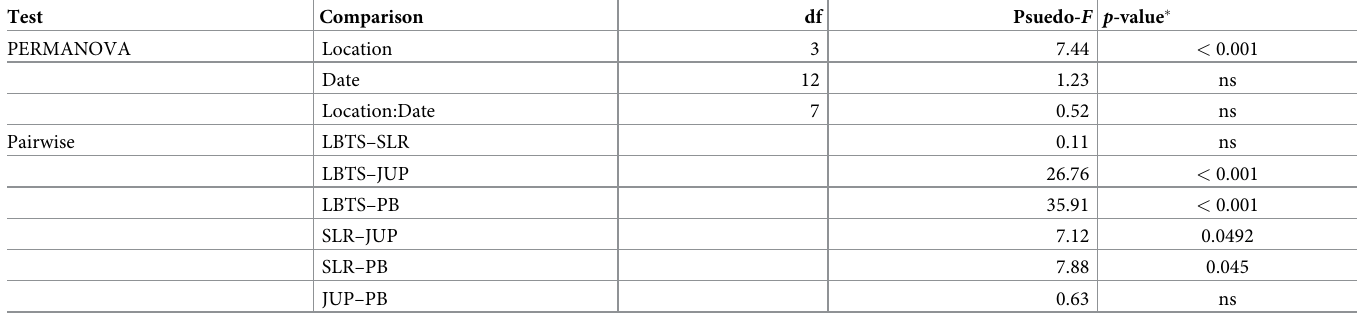
Table 1. Results from univariate-permutational analysis of variance (PERMANOVA) comparing SCTLD prevalence from the roving diver surveys across location and